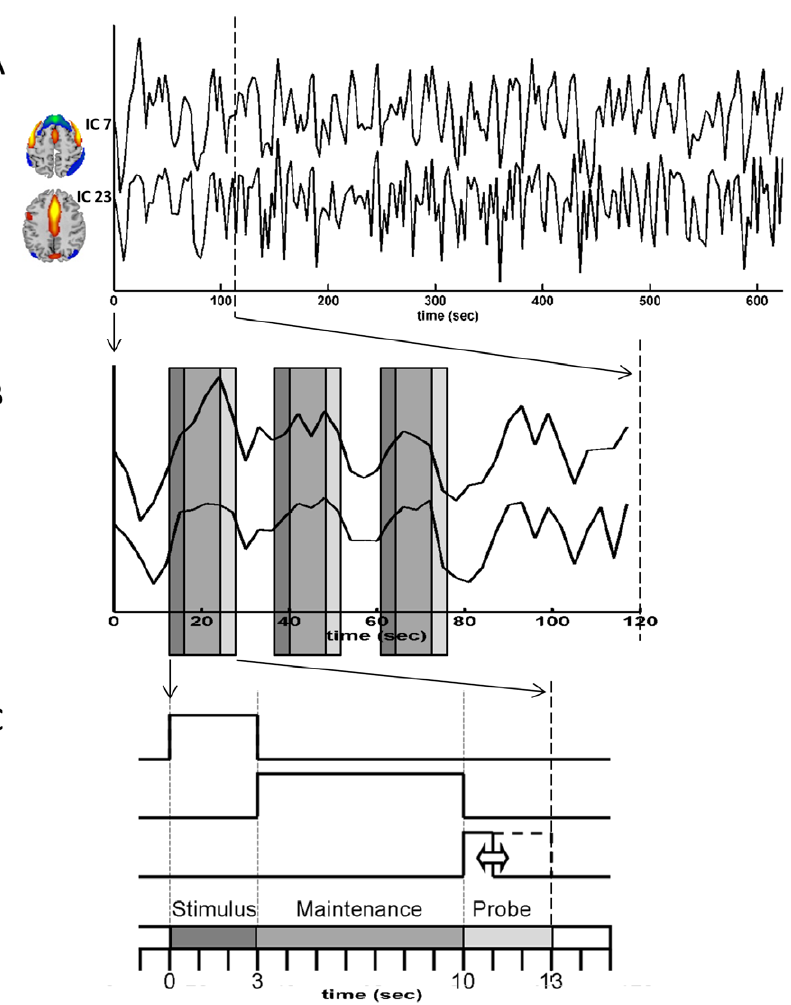
Figure 4. Example time courses and their relationship with the task. A) Example time courses from independent components 7 and 23 from a single participant. The correlation between these two time courses is r =0.65. B) A zoom in on the first 120 seconds of the two time courses. The gray underlying bars represent the three task phases. C) A zoom in on one trial shows the three task phases: stimulus, maintenance and probe.